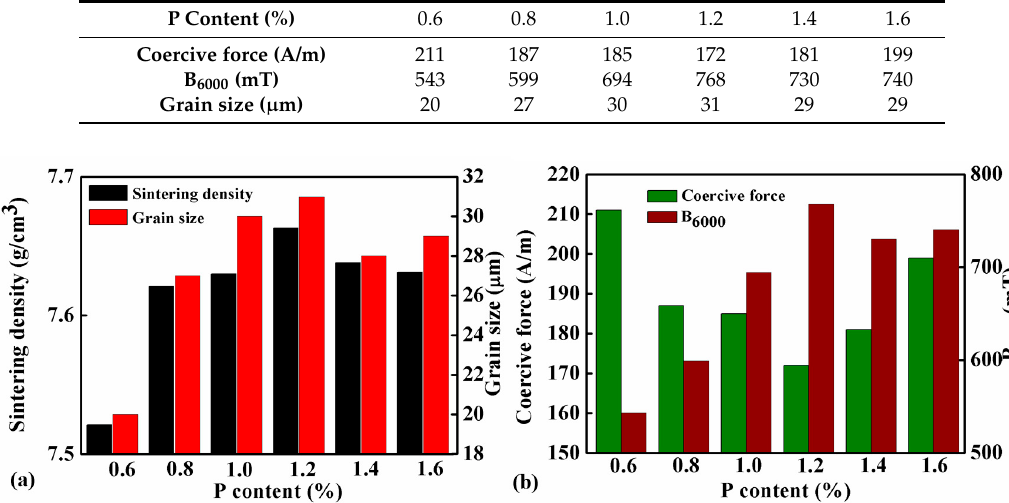
Figure 5. ( a ) Sintering densities and grain sizes, ( b ) coercive force and magnetic induction under 6000 A/m (B 6000 ) of samples with different P contents sintered at 1000 °C for 2 h. Table 3. A summary of coercive forces, magnetic induction, and grain size of Fe-x P (x = 0, 0.6, 0.8,